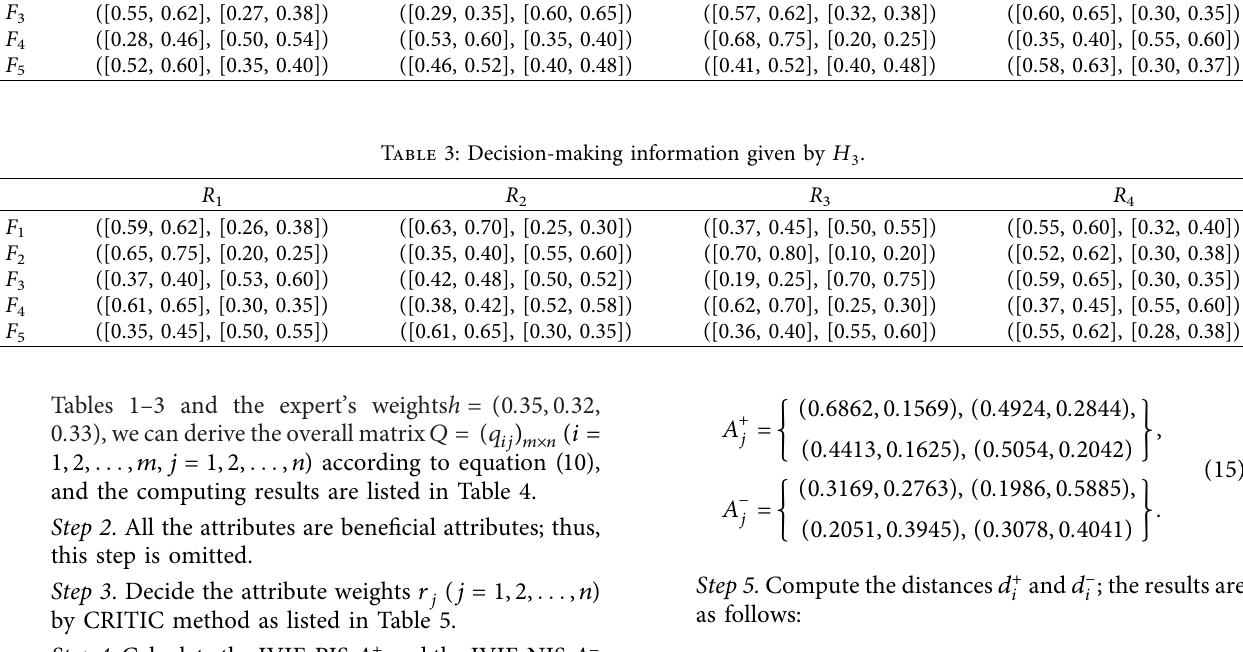
Table 1: Decision-making information given by H